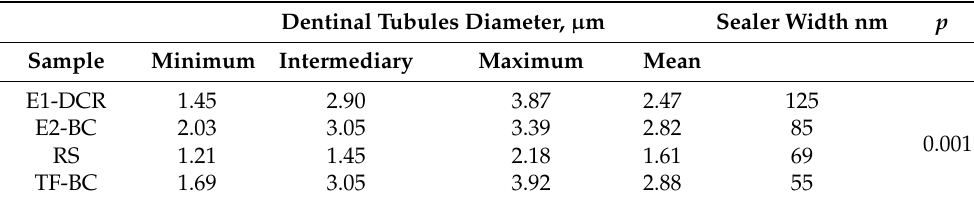
Table 1. Atomic force microscopy values for dentinal tubules diameter and sealer